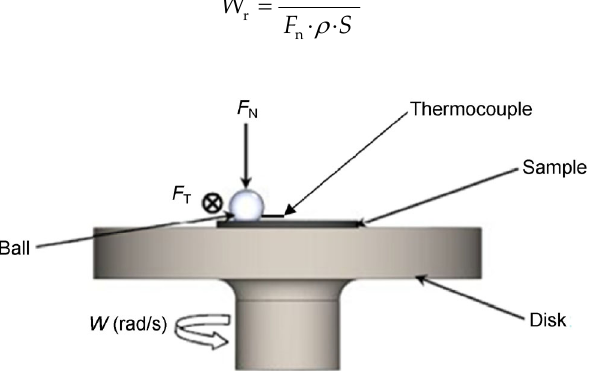
Fig. 2 Pin-on-disc